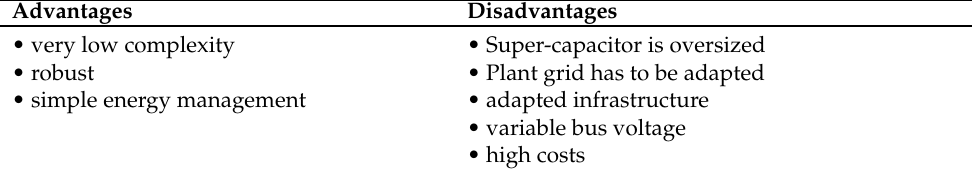
Figure 6. Topology II: Auxiliary circuits and drives are connected directly to the super-capacitor. The bus voltage is equal to the super-capacitor voltage, which depends on the state of charge. Table 9. Advantage and disadvantages of Topology